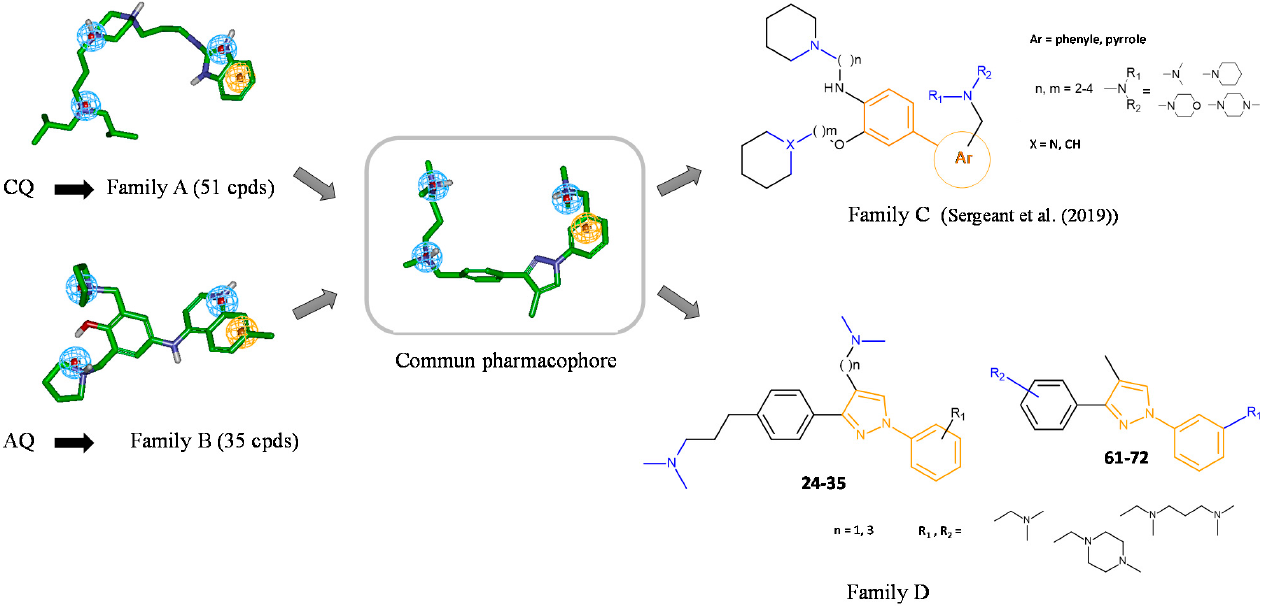
Figure 2. Design of a biphenylpyrazole series based on families A and B. Structure of compounds A1 and B1, representative compounds of families A and B, respectively. Ligand-based approach leading to biaryl family C [17,22] and diphenylpyrazole family D. Compounds 24 – 35 and 61 – 72 are those studied in this paper.